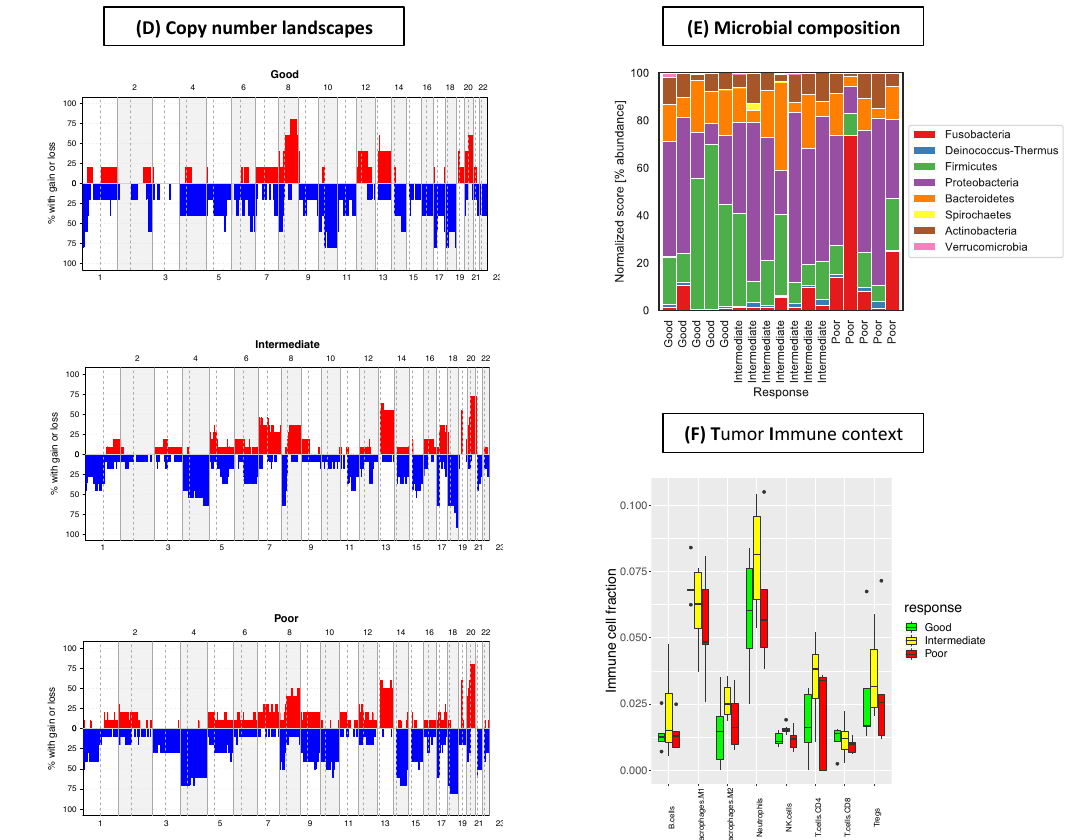
Figure 2. Genomic and transcriptomic landscape by treatment response category. ( A ) Single nucleotide variants (SNV) count. ( B ) Indel count. ( C ) Copy number alteration burden as a proportion of the genome. ( D ) Frequency of copy number alterations (CNAs) by chromosome arm. ( E ) Microbial abundance identified in RNA-seq data. ( F ) Immune composition of B cells, macrophages, neutrophils, NK cells, CD4 + T cells, CD8 + T cells, and regulatory T cells identified from RNA-seq